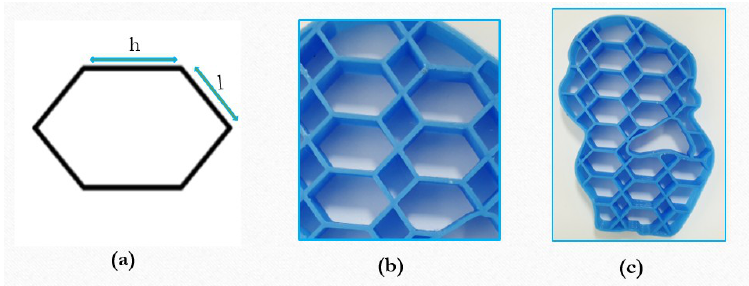
Figure 4. The irregular hexagonal element with larger width, ( a ) element geometry ( b ), ( c ) outputs.